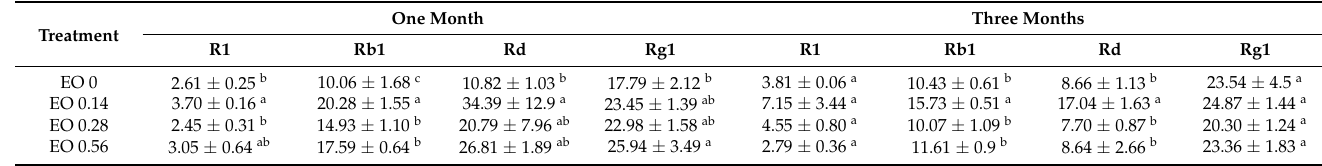
Table 1. Variation of Notoginsenoside R1 (R1), Ginsenoside Rb1 (Rb1), Ginsenoside Rd (Rd), and Ginsenoside Rg1 (Rg1) content under different EO treatments. The concentrations of EO in the soil were 0 mg/g (control), 0.14 mg/g (low concentration), 0.28 mg/g (medium concentration), and 0.5 mg/g (high concentration). Different letters in the same column indicate significant differences ( p < 0.05) between the EO levels at each growth stage.